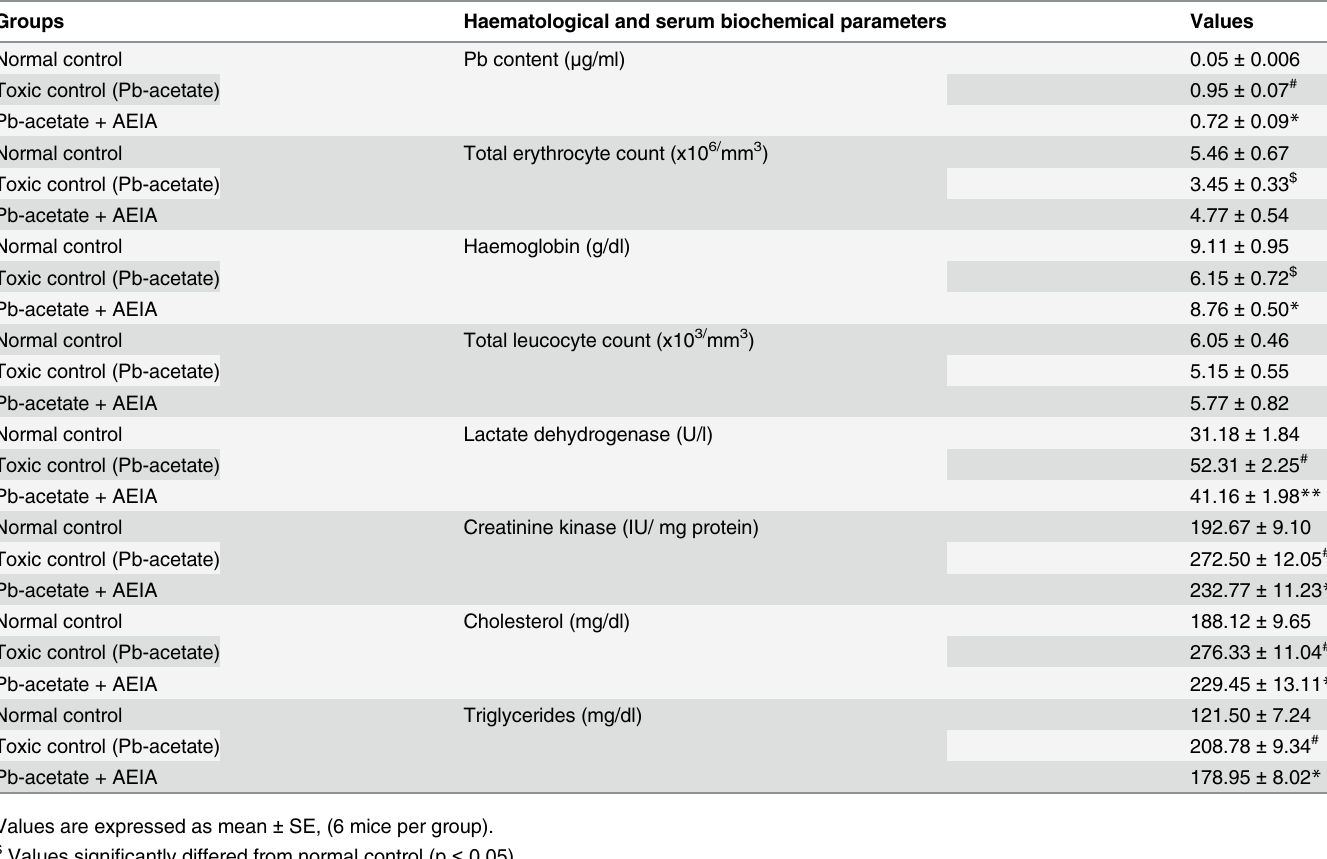
Table 1. Effect on haematological and serum-biochemical parameters in the absence (Pb-acetate) and existence of AEIA (AEIA + Pb-acetate) in mice. Groups